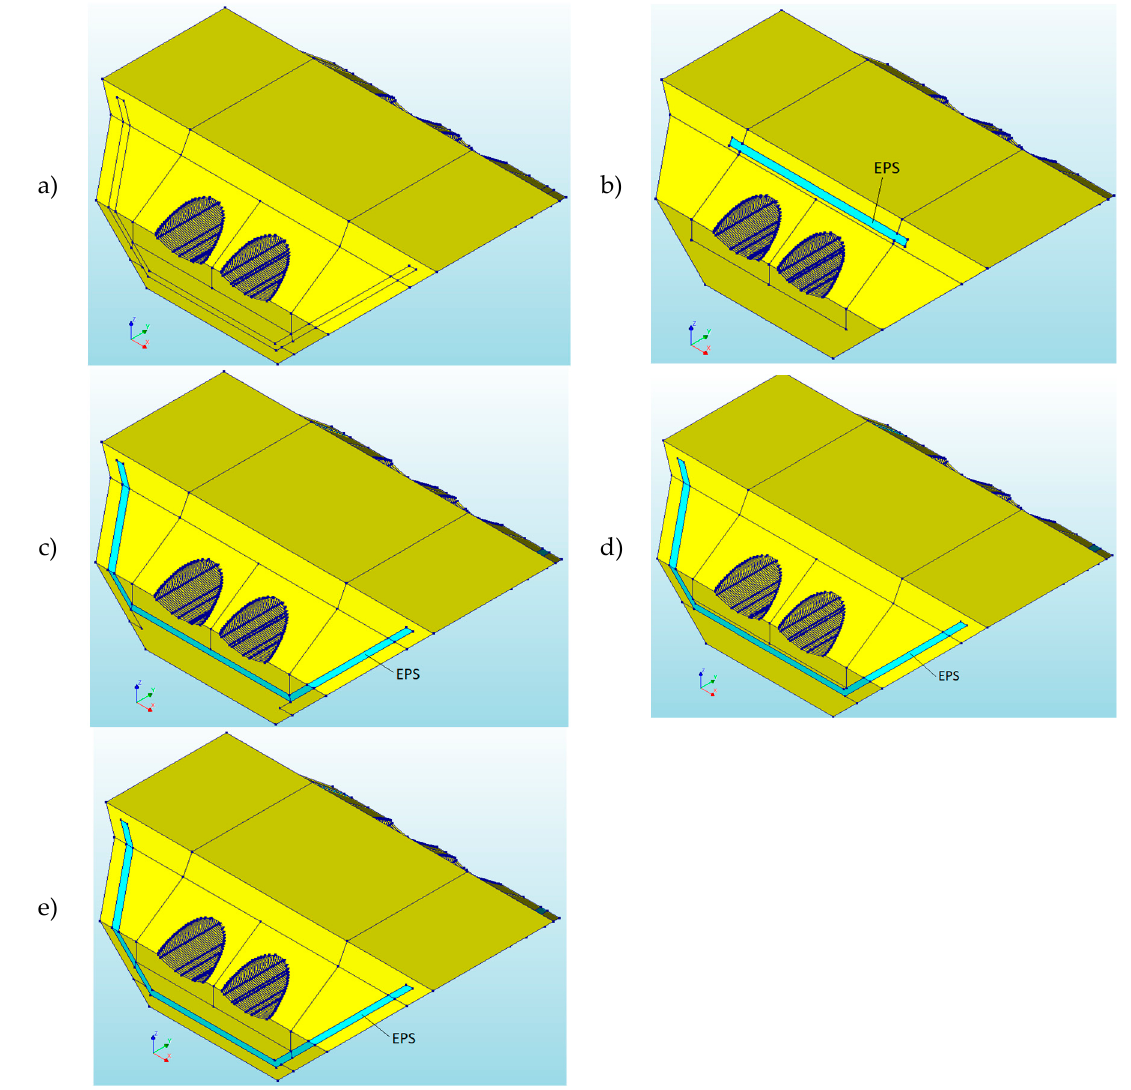
Figure 5. Numerical models of the soil–steel bridge with various locations of the expanded polystyrene (EPS) geofoam: ( a ) I, ( b ) II, ( c ) III, ( d ) IV, and ( e ) V.